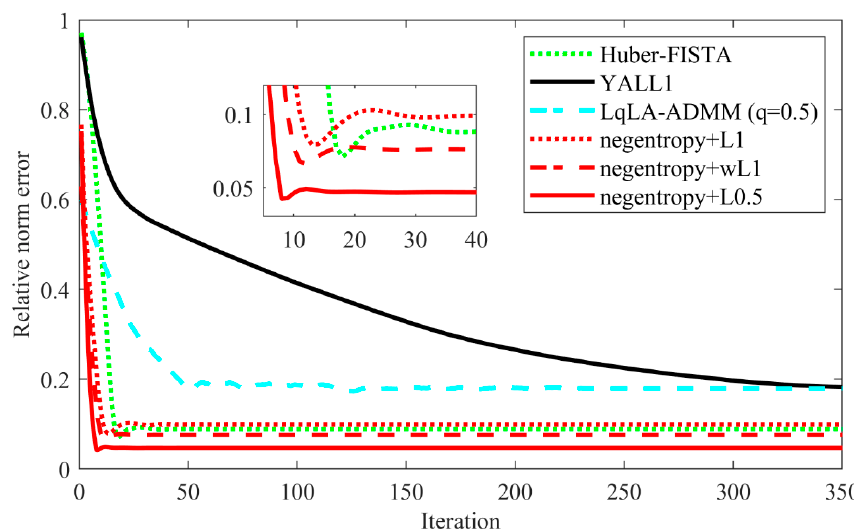
Figure 11. Relative norm error performance versus iterations.